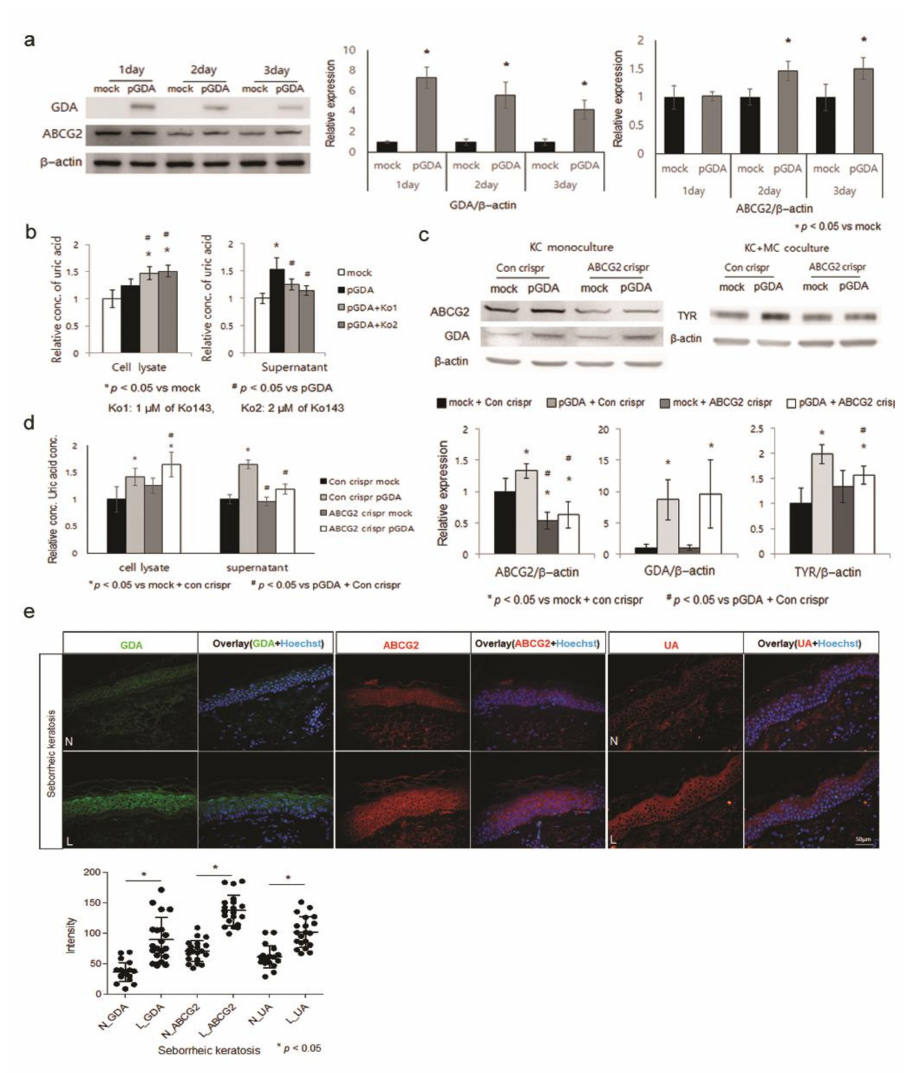
Figure 2. Uric acid is secreted from keratinocytes through ABCG2. ( a ) Western blot analysis for relative ratios of ABCG2 protein levels in keratinocytes after GDA overexpression. ( b ) Uric acid assay determining concentrations of uric acid in